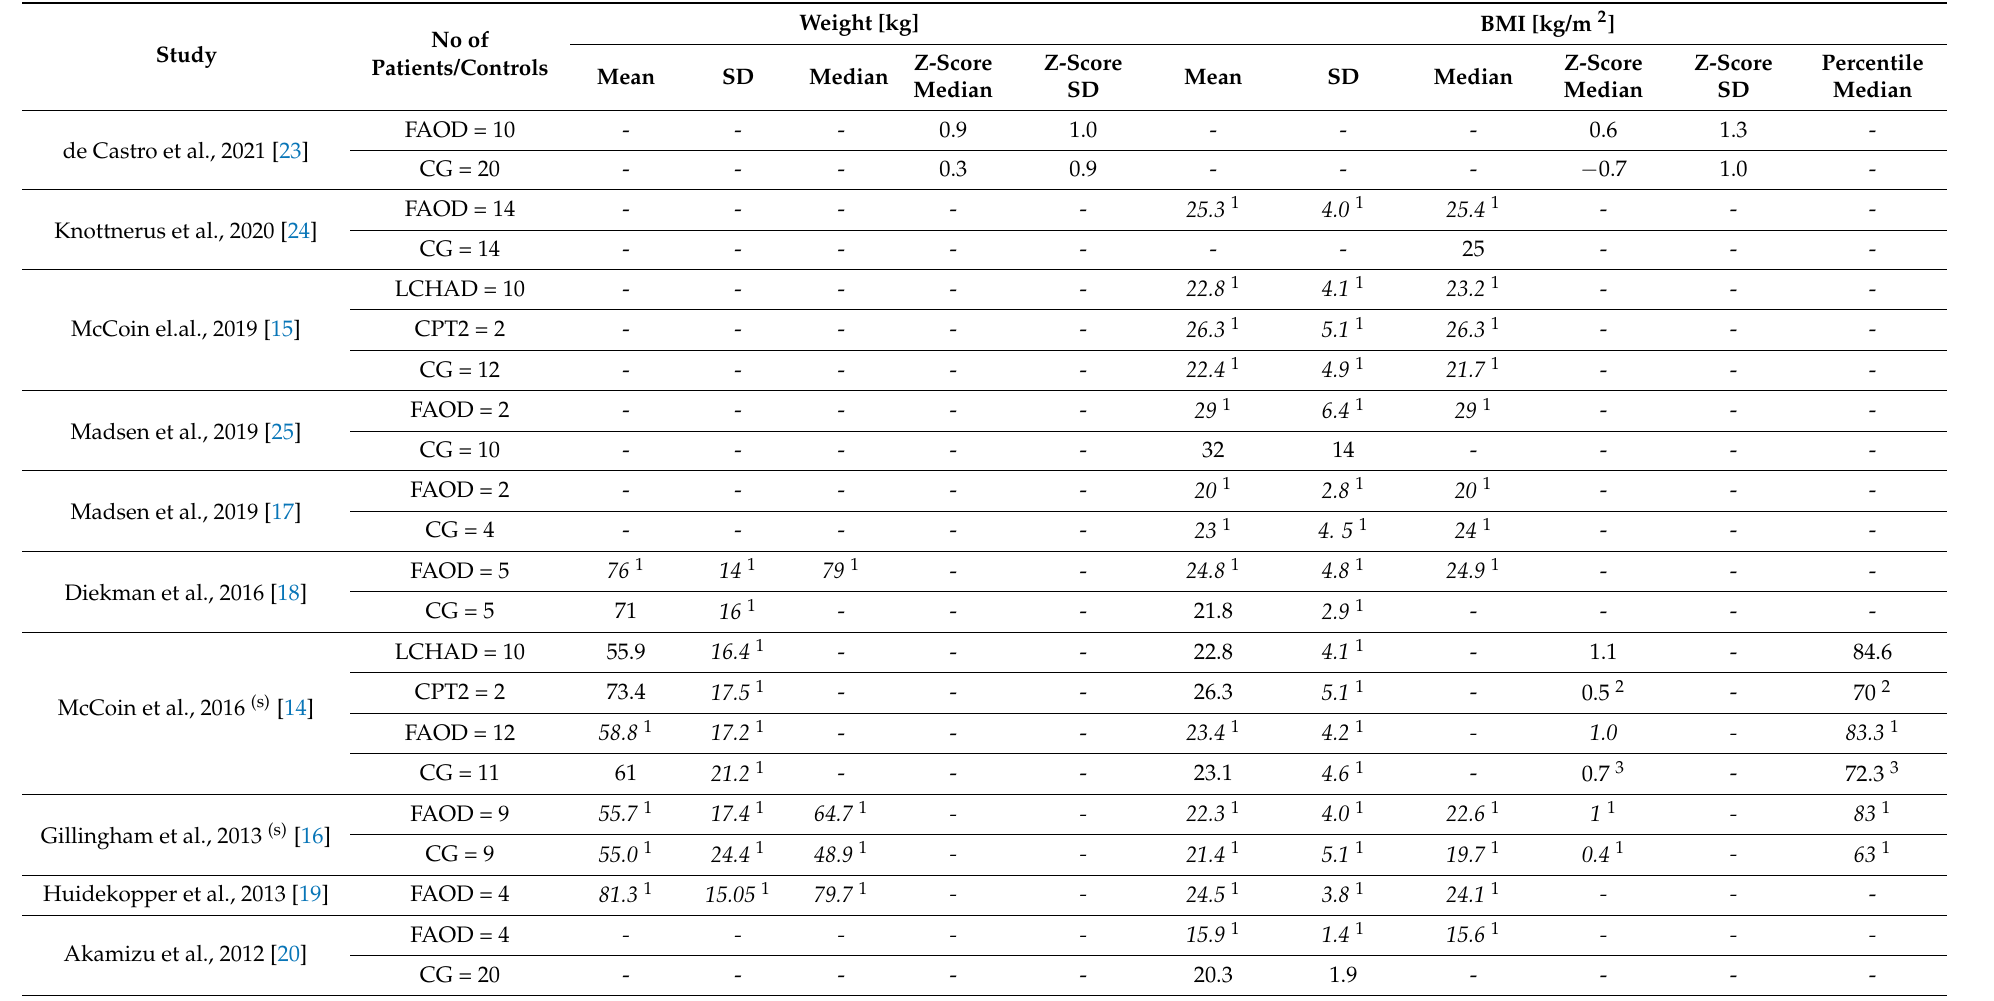
Table 3. Data extracted form studies with control